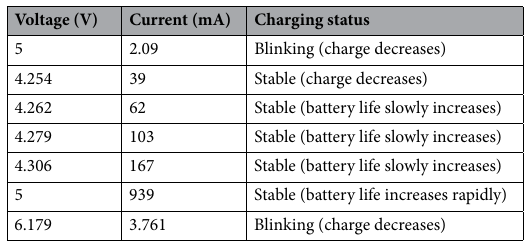
Table 1. A typical smartphone’s current and voltage requirements for charging.